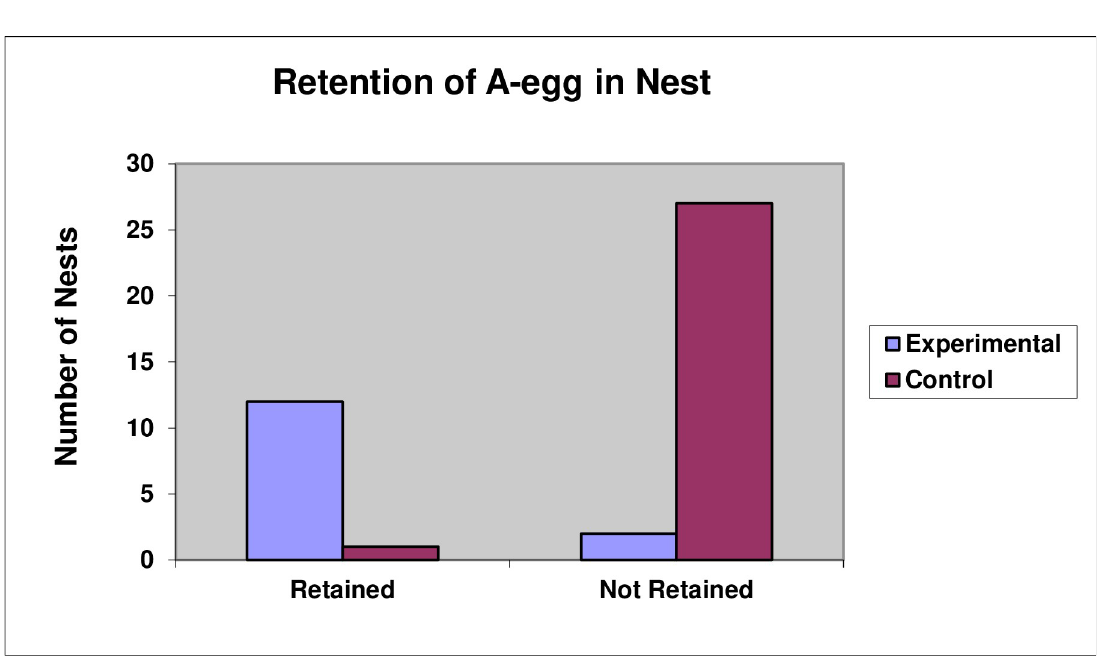
Fig 10. Retention of A-eggs in Experimental and Control nests.